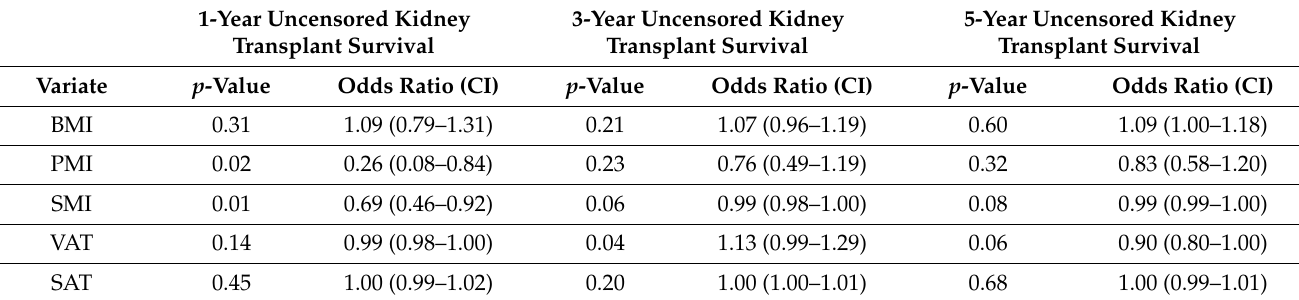
Table 5. Cox regression analysis of 1-year, 3-year and 5-year uncensored kidney transplant sur- vival with the variates BMI and AI-derived body composition parameters PMI, SMI, VAT and SAT. AI = artificial intelligence, BMI = body mass index, CI = confidence interval, PMI = psoas muscle index, SMI = skeletal muscle index, SAT = subcutaneous adipose tissue, VAT = visceral adipose